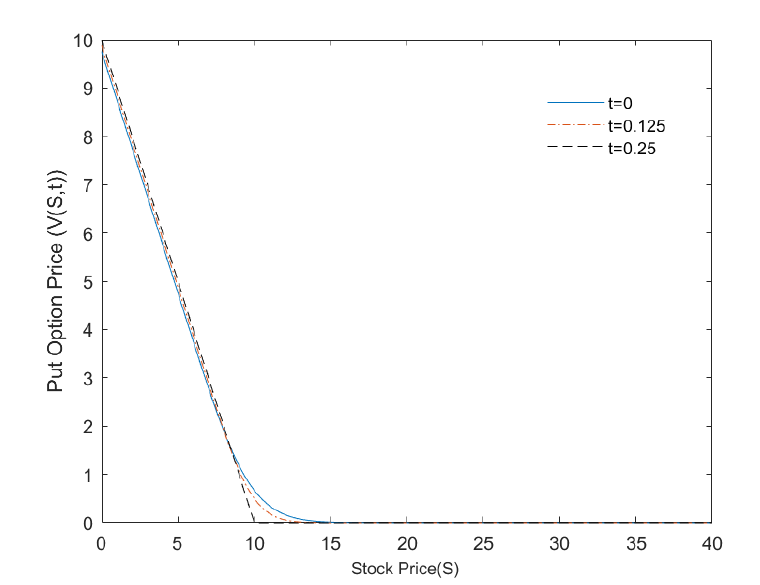
Figure 2. Prices of the linear European put option for different time values.